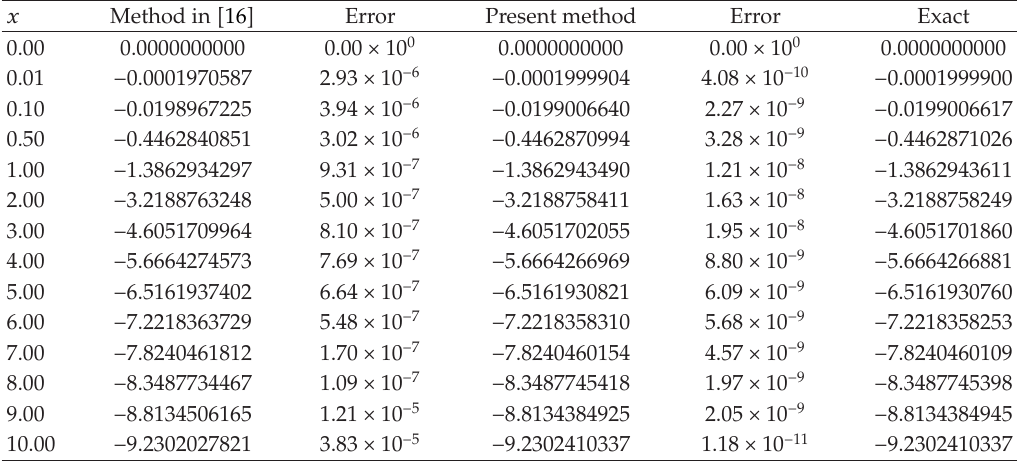
Table 2: Comparison of y (cid:3) x (cid:4) between present method, method in (cid:7) 16 (cid:8) and the exact values for Example